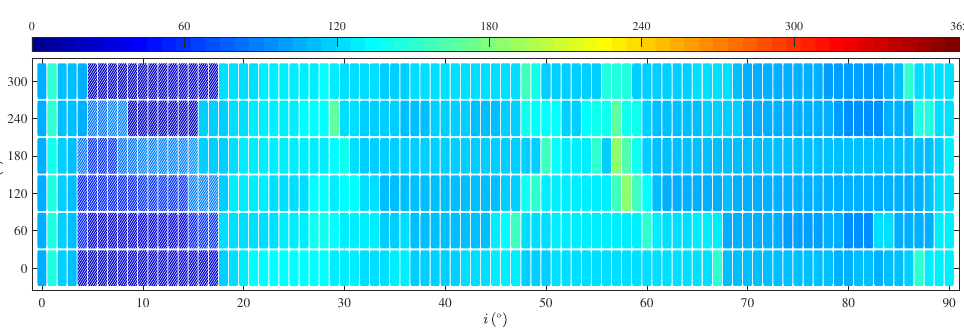
Figure 16. With (cid:107) T (cid:107) = 20 mN, the lifetime of spacecraft in the 30 km-altitude near-circular orbit.